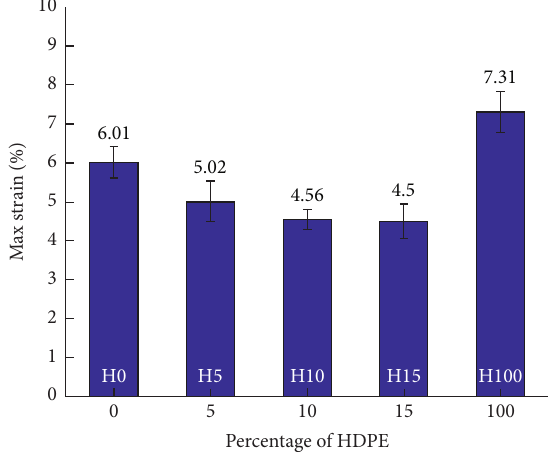
Figure 12: Effect of HDPE percentage on the flexural strength of the PBT/HDPE blends.